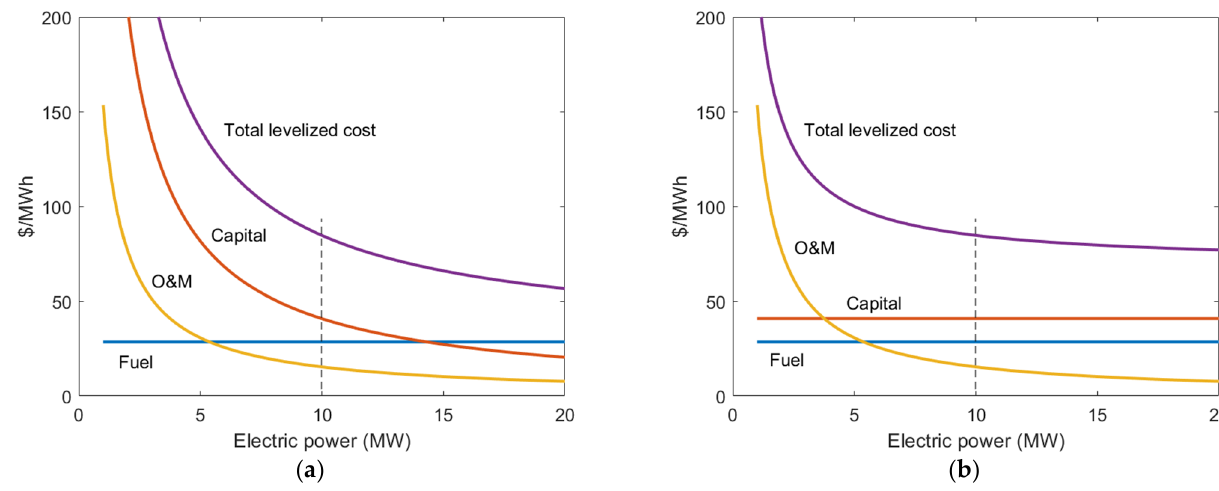
Figure 8. NB levelized electricity costs vs. electric power for ( a ) fixed total capital cost (USD) and ( b ) fixed unit cost